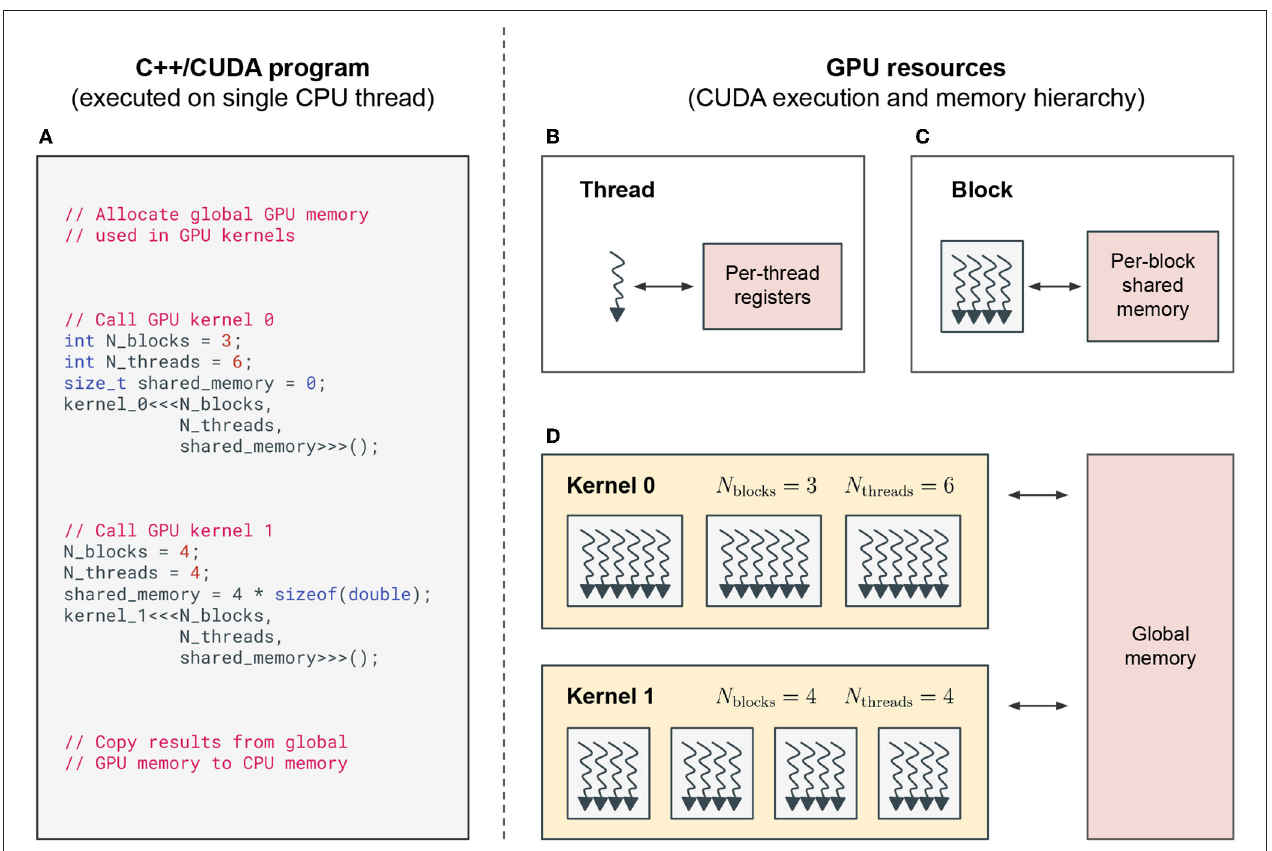
FIGURE 2 | CUDA programming model. (A) A simplified, exemplary C++/CUDA program that is executed on a single CPU thread. The CPU manages memory on the GPU and calls CUDA kernels that are executed on the GPU. (B–D) GPU resources and CUDA execution and memory hierarchy when running CUDA kernels on the GPU. (B) Each CUDA thread on a GPU has access to its own memory registers. (C) Each CUDA block groups together multiple CUDA threads. All threads of the same block have access to the same shared memory. (D) CUDA kernels can be executed with different numbers of blocks N blocks , threads per block N threads and shared memory per block. The kernels called in (A) are executed sequentially on the GPU, while multiple CUDA blocks are executed in parallel on the streaming multiprocessors (SMs) of the GPU. The example program in (A) calls kernel 0 without any shared memory and kernel 1 with enough shared memory to store one floating point number per thread. This memory could e.g., be used to calculate the sum of a variable over all threads in a block, using fast shared memory instead of slow global